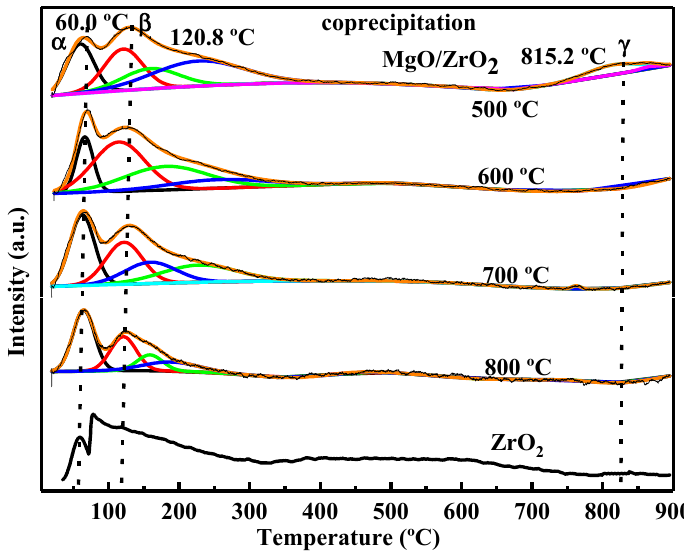
Figure 9. CO 2 -TPD patterns of MgZr-c catalyst prepared by coprecipitation method.